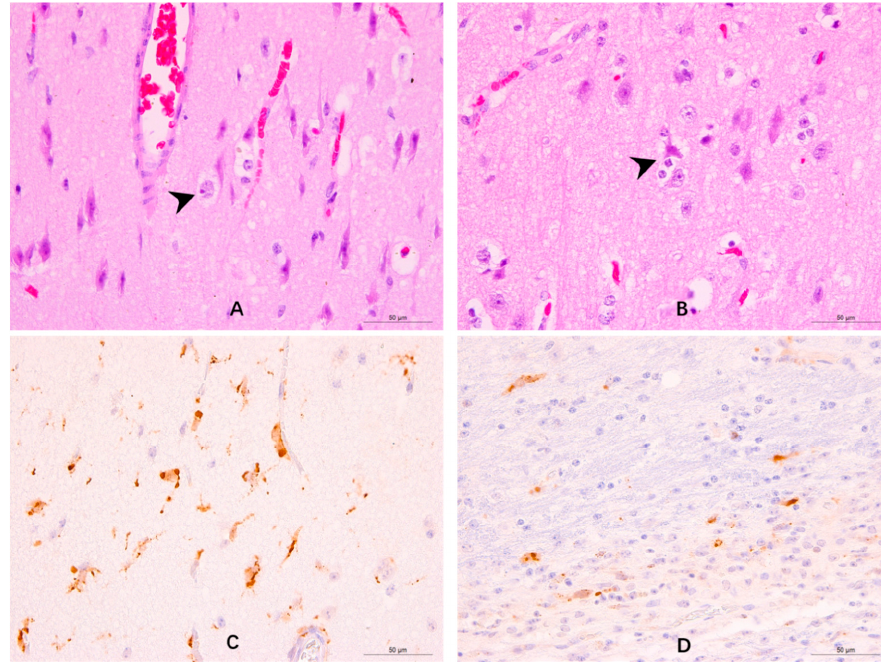
Figure 3. Brain tissue sections of a raccoon dog that died from CDV infection while displaying neurological symptoms [23]. Hematoxylin–eosin staining ( A , B ) and immunohistochemical analysis ( C , D ) of the tissues. Black arrows indicate cytonuclear eosinophilic inclusion bodies in neurons ( A ) and neuronophagia in the cerebral cortex ( B ). CDV-NP proteins (brown staining) were detected in neuronal and glial cells ( C ) and olfactory ensheathing cells ( D ).